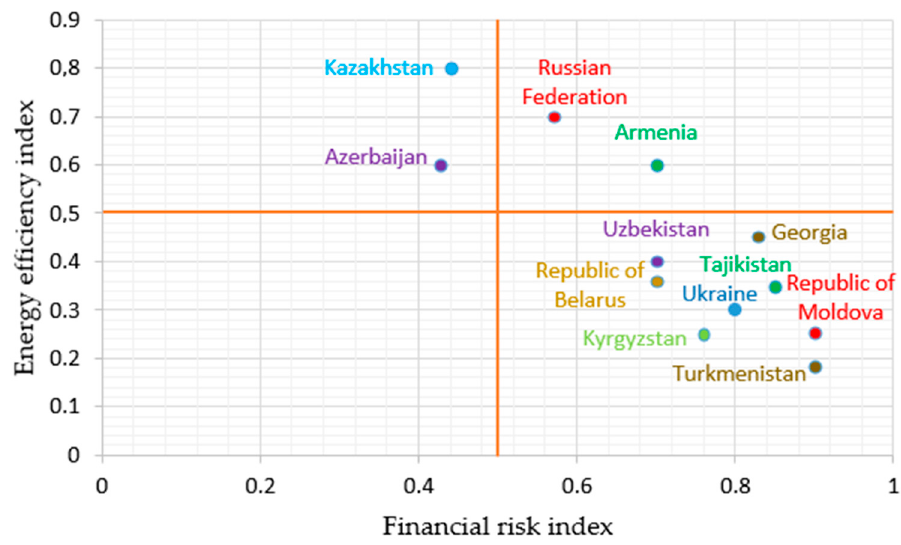
Figure 3. The results of modeling the integral index of energy supply to socially vulnerable segments of the population. Source: authors’ elaboration.